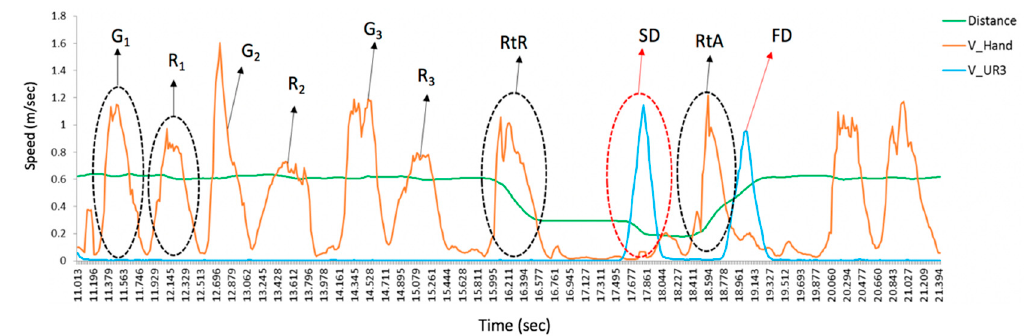
Figure 3. Speed variation of the operator’s hand and robot during the handover process, with G x = reach out to grab the x th building block, x = 1, 2, 3; R x = return to the assembly area with the x th building block; RtR = reach to the robot; RtA = return to the assembly area with the handed over building block; SD = start handover by robot; FD = finish handover by robot.